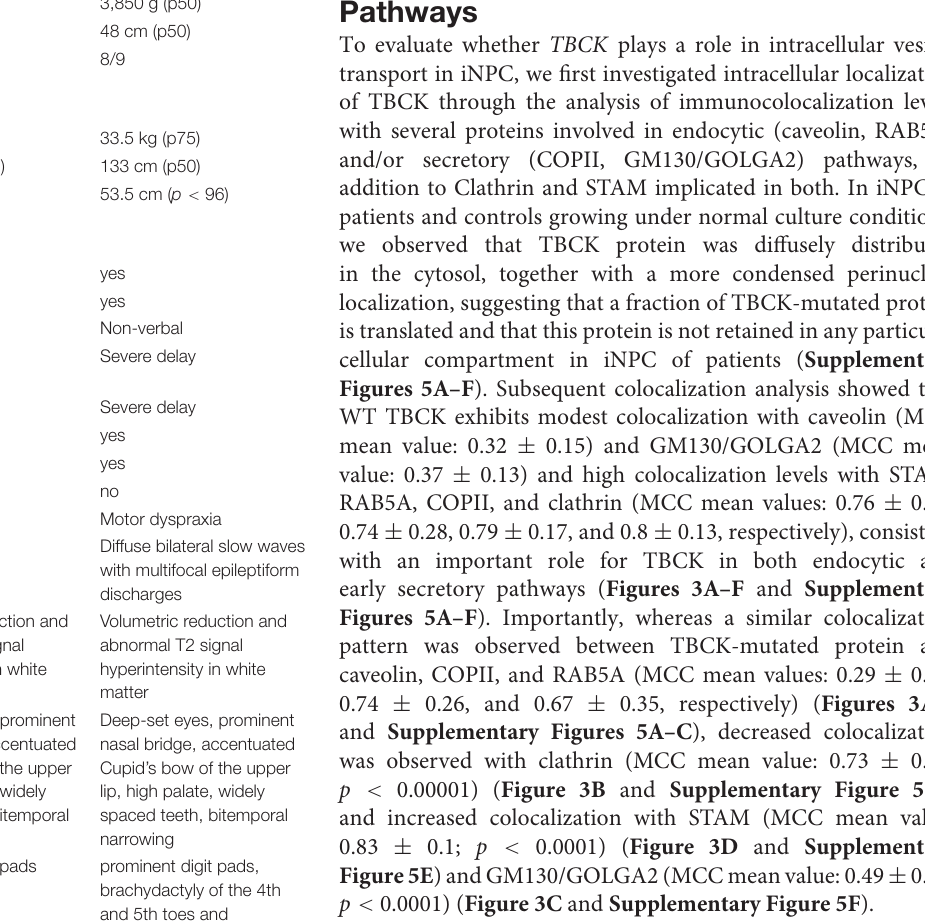
Figure 5E ) and GM130/GOLGA2 (MCC mean value: 0.49 ± 0.14; p < 0.0001) ( Figure 3C and Supplementary Figure 5F